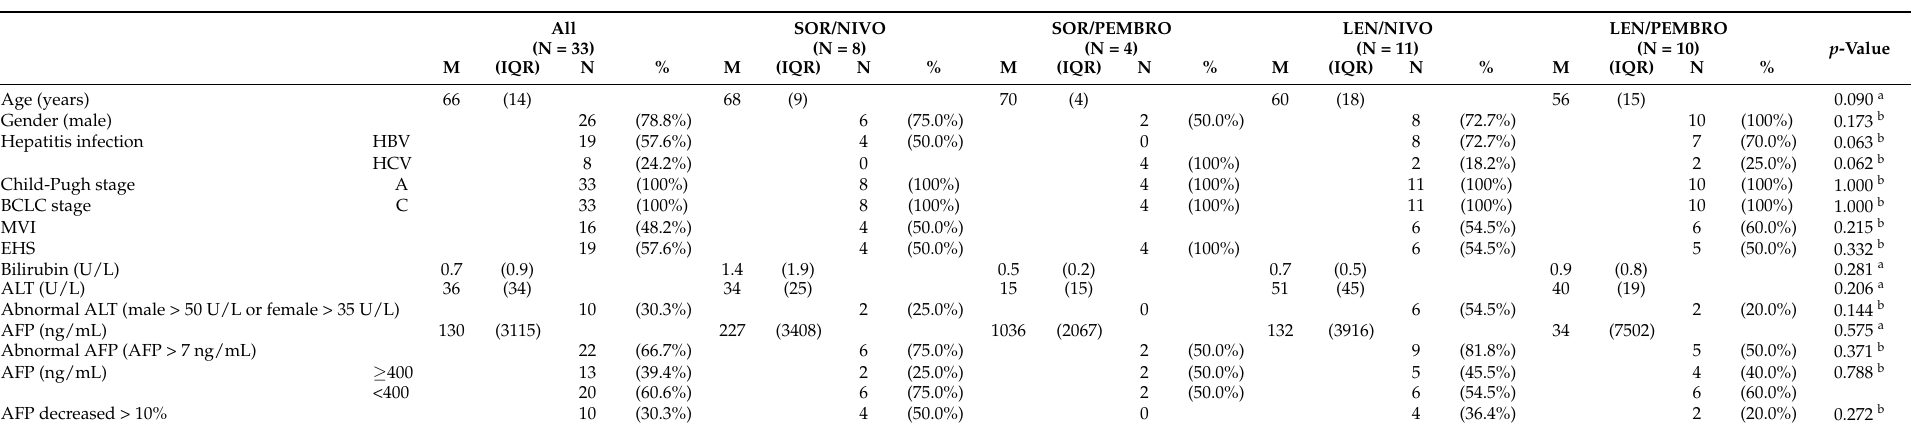
Table 1. General characteristics of